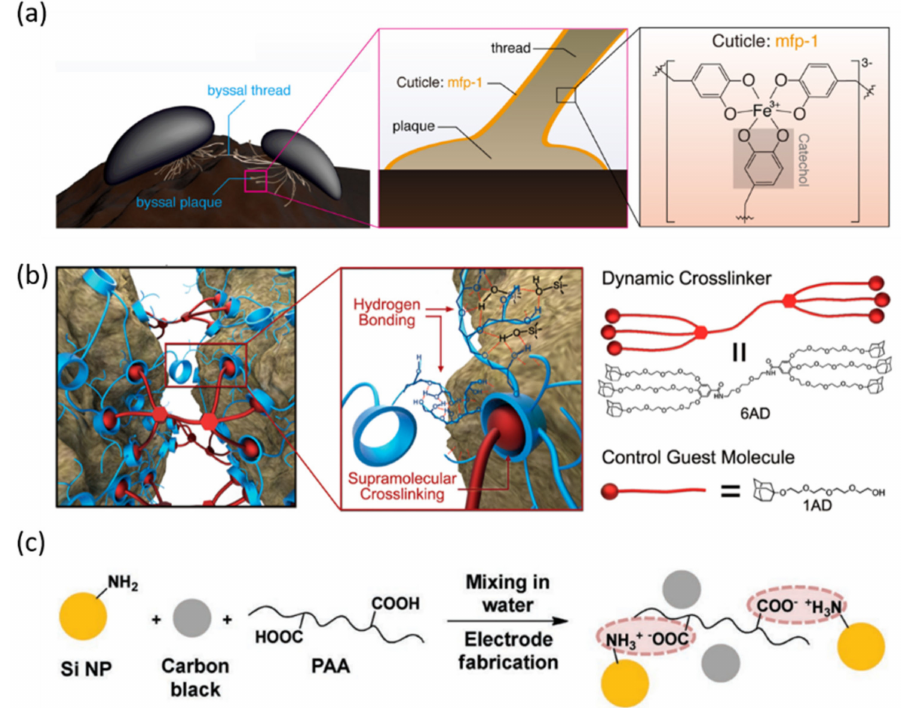
Figure 5. Binders based on other types of dynamic non-covalent bonds for Si-based anodes in LIBs. ( a ) mussel byssal thread with wet adhesion via Fe 3+ -catechol complex [72]. Copyright 2019, American Chemical Society; ( b ) proposed working mechanism of dynamic cross-linking based on host–guest interactions [73]. Copyright 2015, American Chemical Society; ( c ) the formation of interfacial ionic bonds between Si NPs and PAA binder [74]. Copyright 2017, John Wiley and